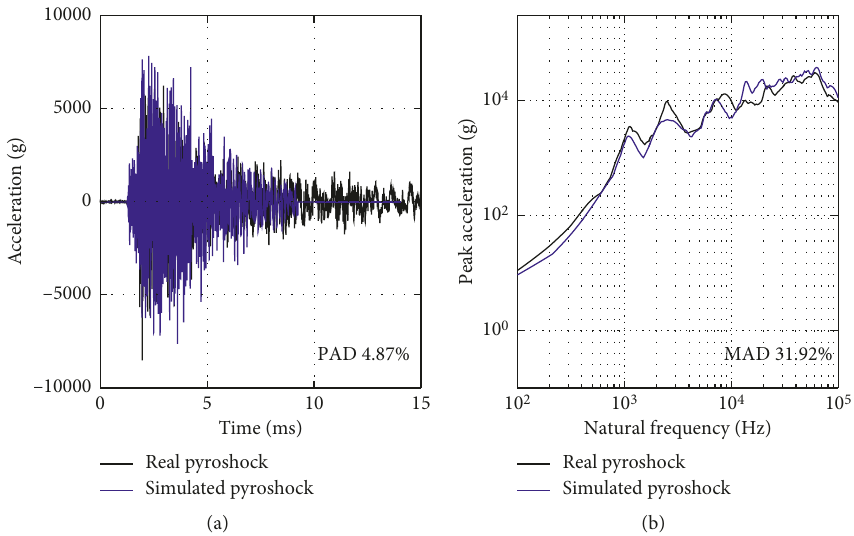
Figure 8: Simulation results of 1/2 inch explosive bolt-induced shock at the verification point.